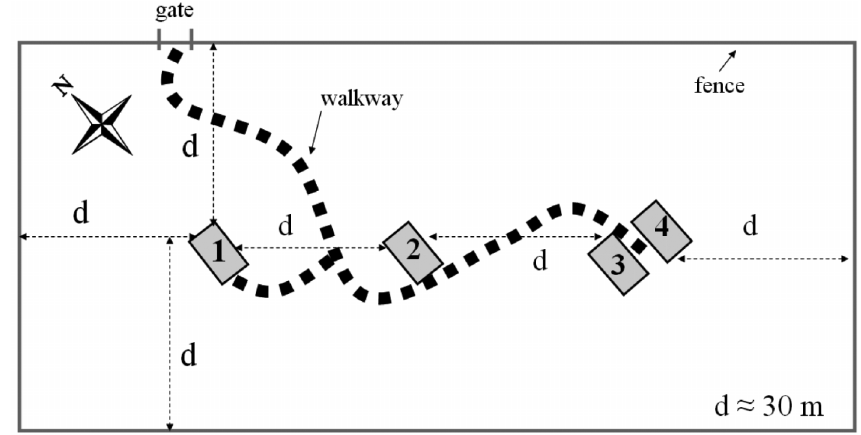
Fig. 2. Plan of Duronia station. The chalet 1 contains the acquisition systems. The chalets 2, 3 and 4, contain the